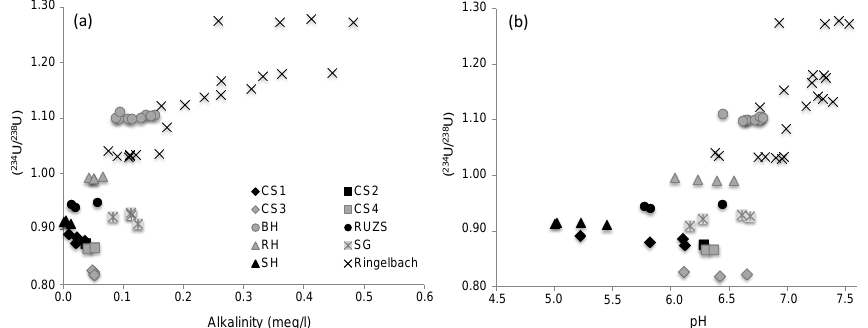
Figure 10. Variations of ( 234 U / 238 U) AR vs. (a) alkalinity and (b) pH in the springs from the Strengbach and Ringelbach (Shaffauser et al., 2014) watersheds.